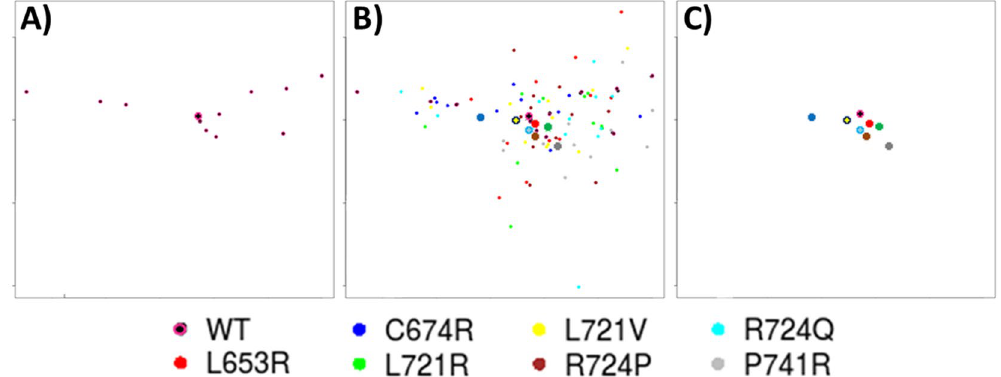
Figure 10. Sammon map of the MD. ( a ) The WT reference system and its barycentre, ( b ) all the variant simulations and the barycentre of each system, and ( c ) only the barycentres. The MD are shown as dots, and corresponding barycentres as plain